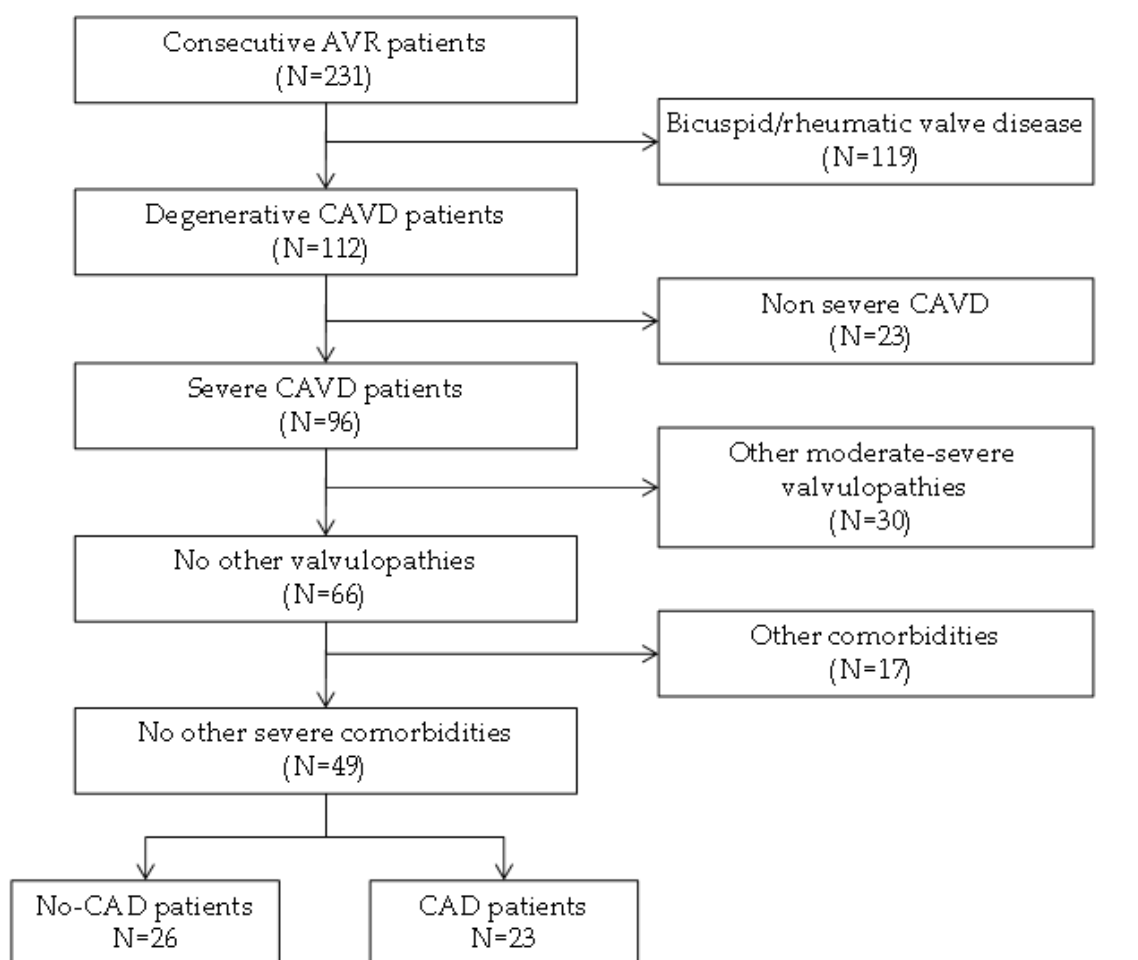
Figure 1. Flowchart of patient recruitment and inclusion. In total, 231 consecutive patients who were diagnosed with aortic stenosis and recommended for surgery were selected. After the application of exclusion limits, 26 and 23 patients without and with coronary artery disease remained. Finally, 22 patients of each group were selected to avoid significant differences between groups. CAVD, calcific aortic valve disease; CAD, coronary artery disease. Table 1. Clinical characteristics of the subjects of study. CAVD, calcific aortic valve disease without coronary artery disease; CAVD + CAD, calcific aortic valve disease with coronary artery disease; M/F, male/female; p , p ‐ value.